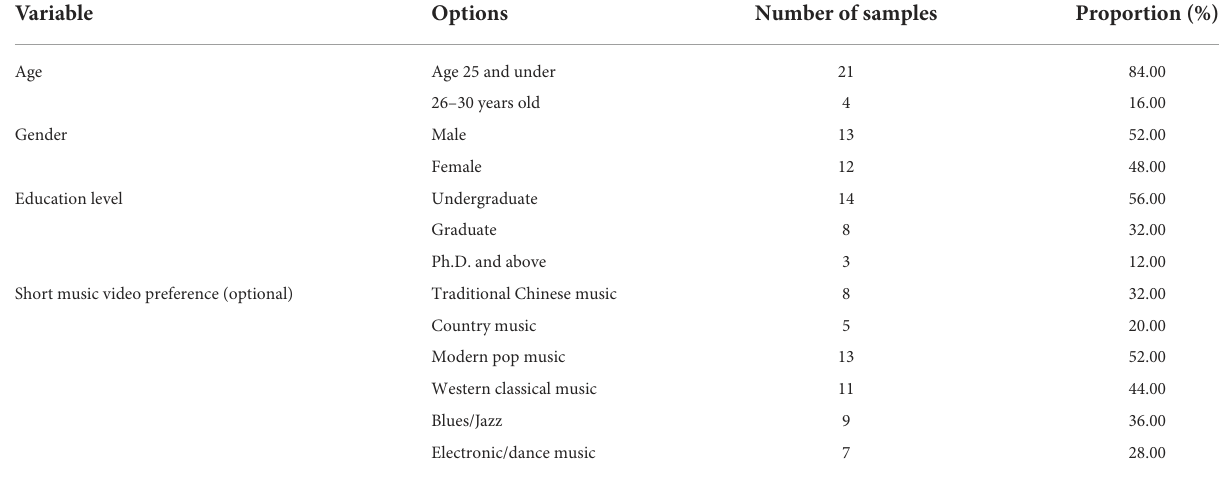
TABLE 1 Basic information on the research